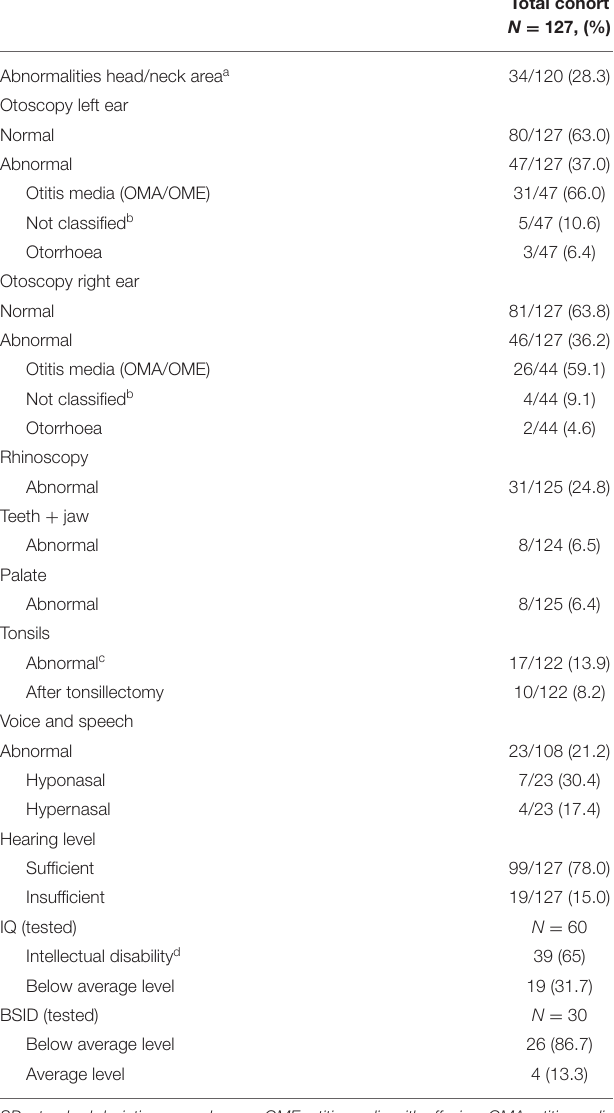
TABLE 2 | Otologic examinations and additional developmental tests in children with developmental language disorder